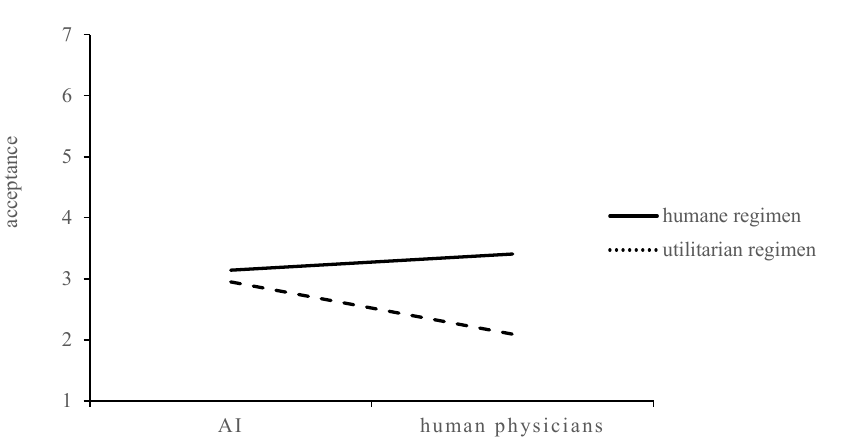
Figure 5. Sense of the regimen moderating effect to acceptance.